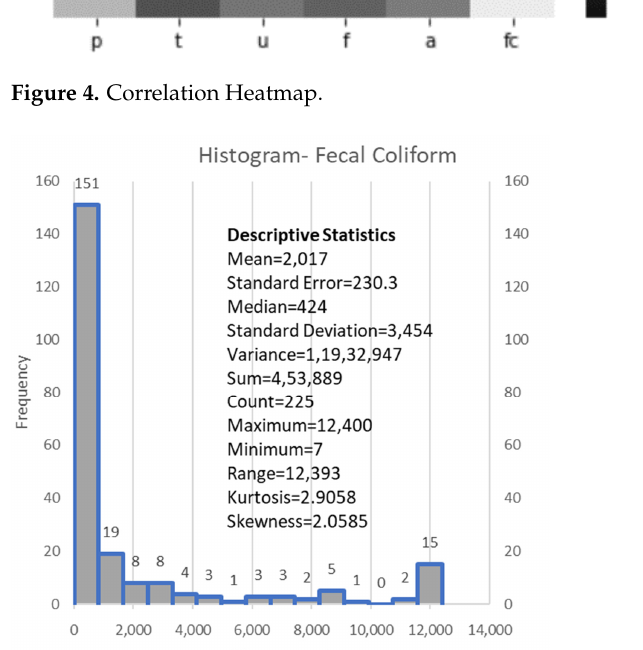
Figure 5. Histogram of Fecal Coliform (FC).